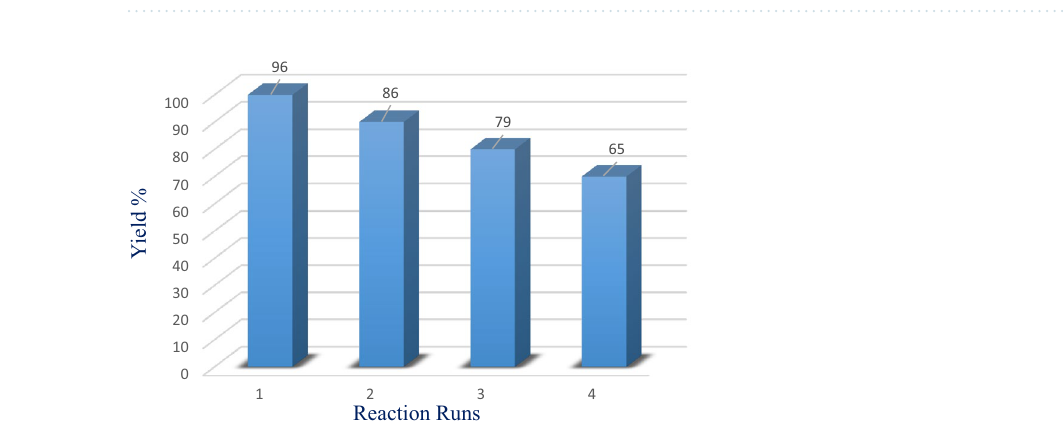
Scheme 6. Synthesis of 14a derivative.